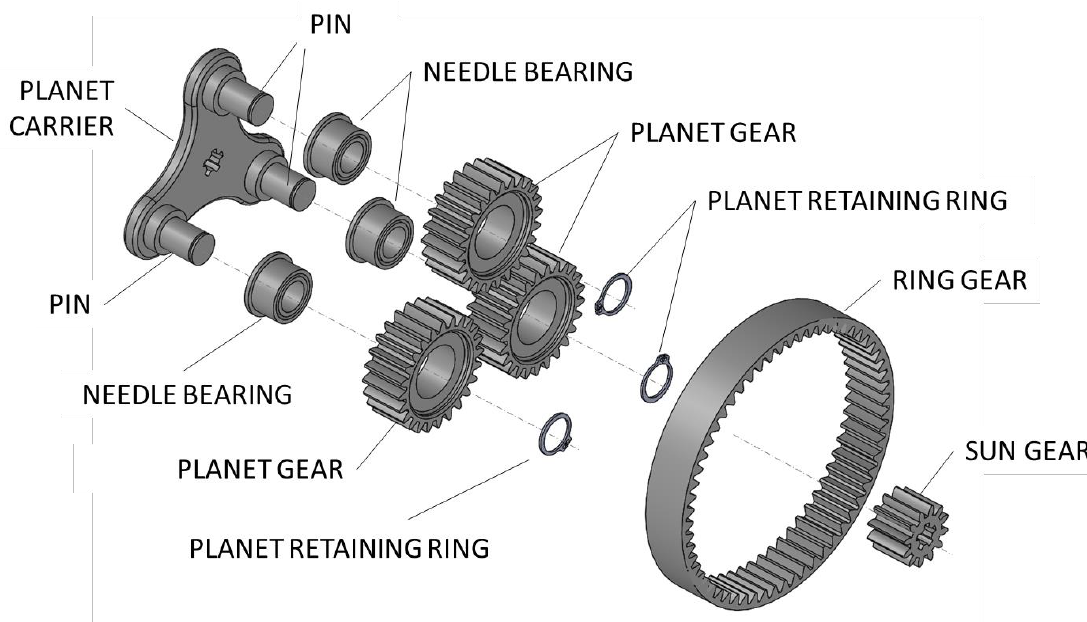
Figure 8. Exploded view of the main components of the planetary gear set as a part of the final reduction.